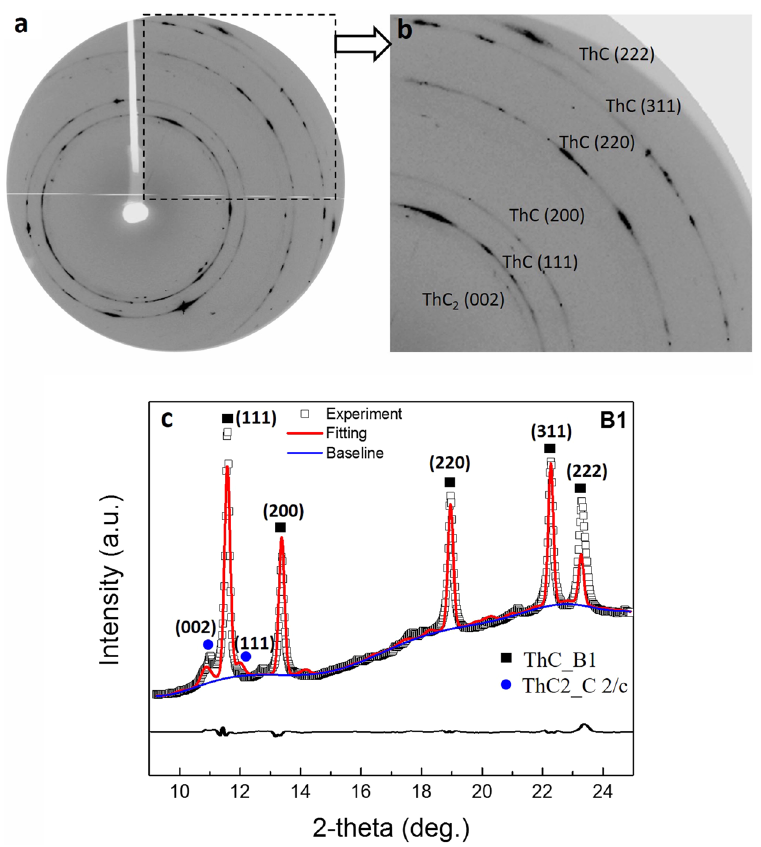
Figure 1. X-ray diffraction (XRD) result of ThC powder at initial high pressure 1.23 GPa. ( a ) The original 2D diffraction pattern. The indexes are shown on ( b ). The enlarged area from ( a ) with indexation of diffraction peaks. ( c ) The corresponding integrated 1D diffraction pattern and Rietveld refinement result (red line).